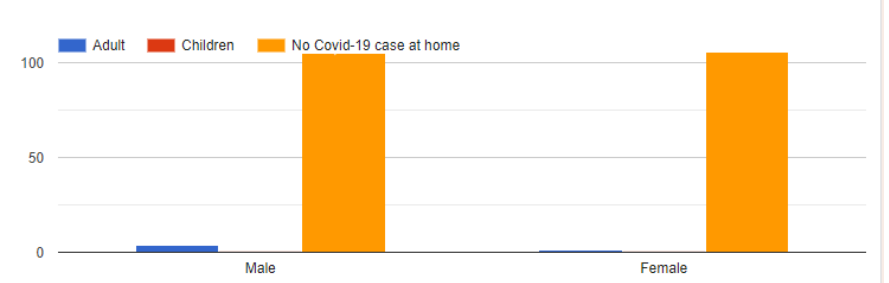
Figure 6: Number of Deaths in Family Due to Covid-19 (Source: Online